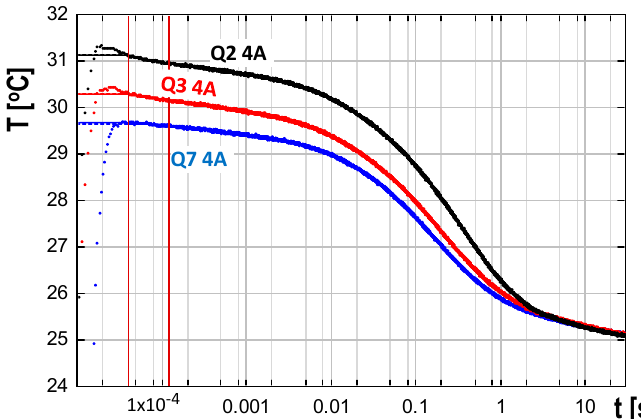
Figure 28. Cooling transients on devices Q2, Q3, and Q7 at 4 A heating and 0.1 A sensing current.